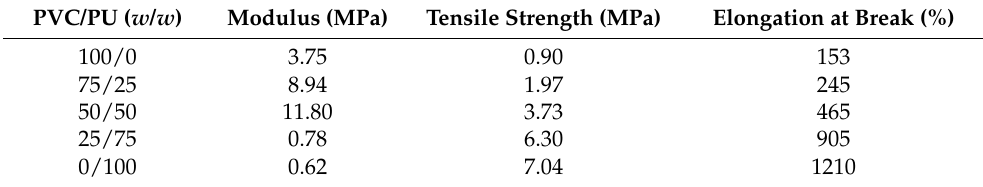
Table 6. Mechanical properties of electrospun PVC/PU nanofiber mats